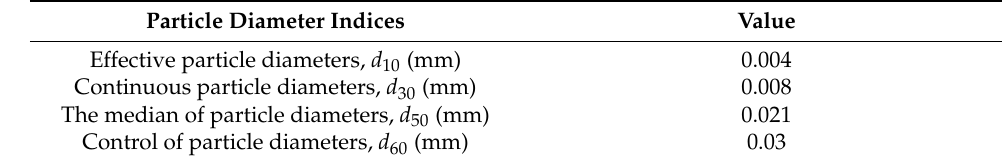
Figure 3. Grain size distribution curve of soil samples. Table 2. Different particle diameter indices of soil